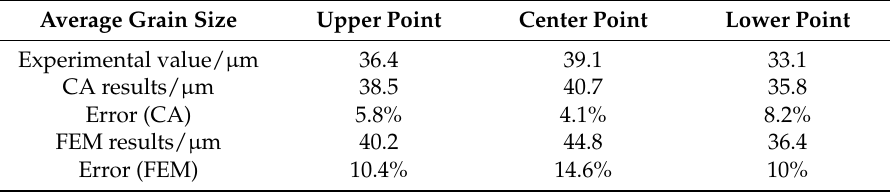
Figure 12. Experimental microstructures at different positions during asymmetrical shear rolling: ( a ) upper point; ( b ) center point; ( c ) lower point. Table 2. Comparisons of simulated and experimental average grain size in asymmetrical shear rolling.